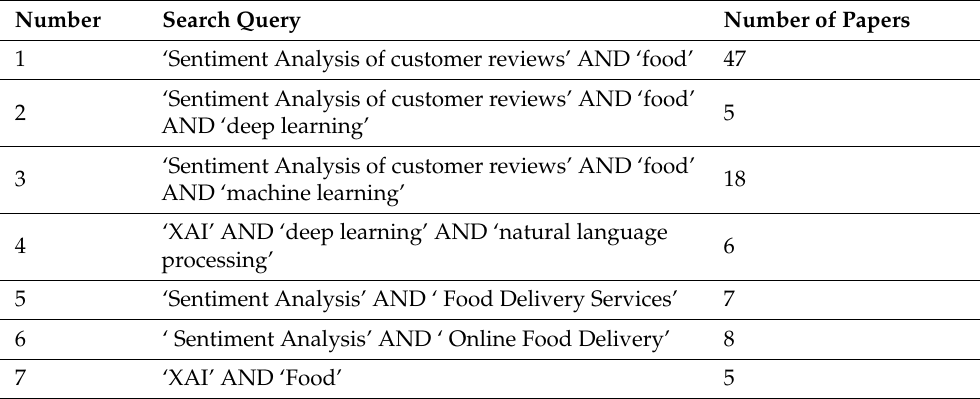
Table 1. Search queries and results showing the number of papers.